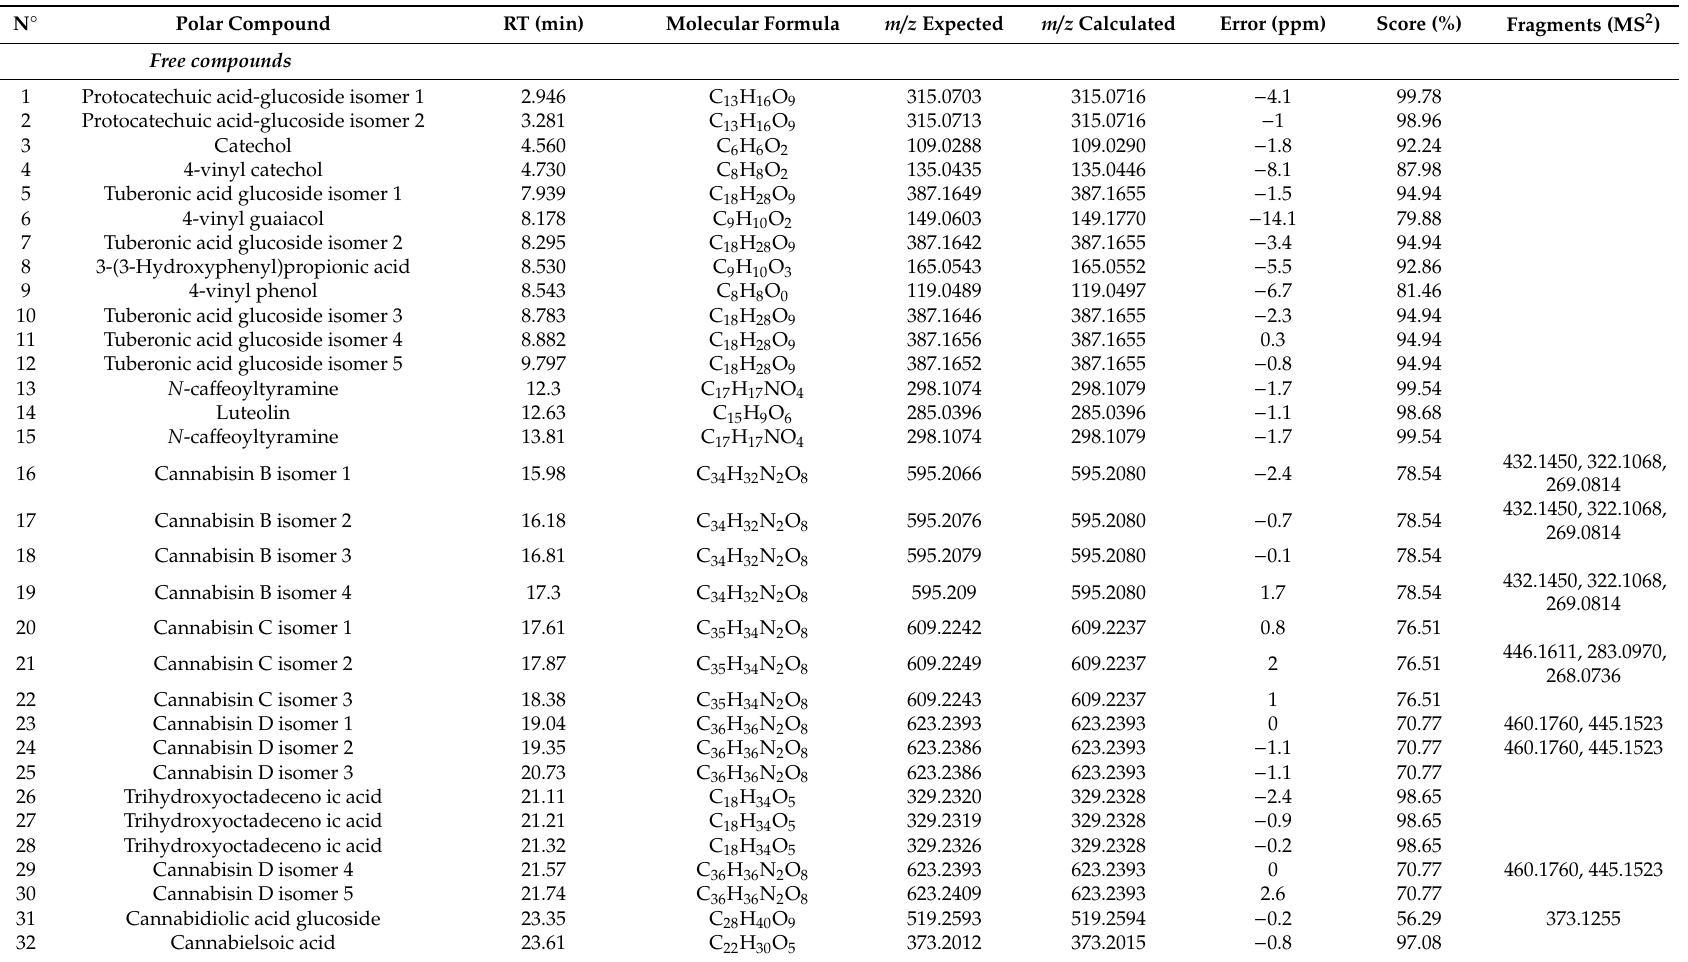
Table 3. Phenolic compounds identified in raw and bioprocessed hemp by HPLC-DAD-ESI-QTOF-MS. H, untreated hemp dough; H X , hemp dough treated